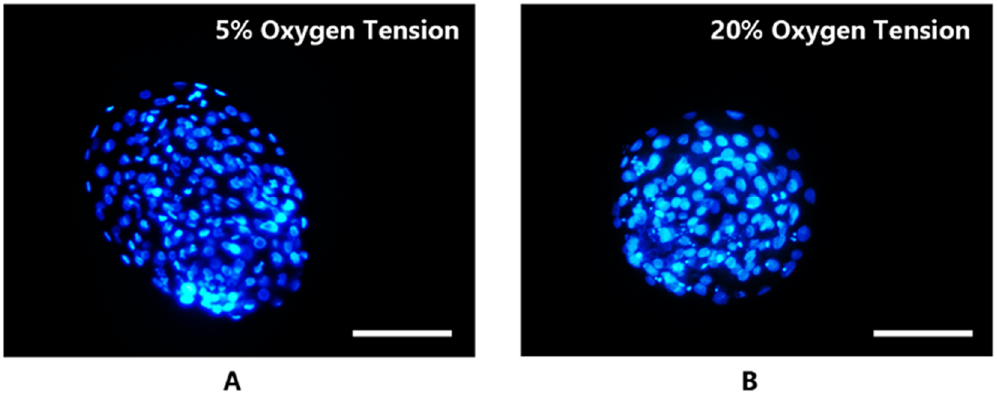
Figure 3. Hatched blastocysts stained with Hoechst 33342 to determine the total cell count. Blastocysts were cultured under 5% ( A ) and 20% ( B ) oxygen tension. The images were captured with microscope (50i; Nikon, Japan) at 200× resolution.